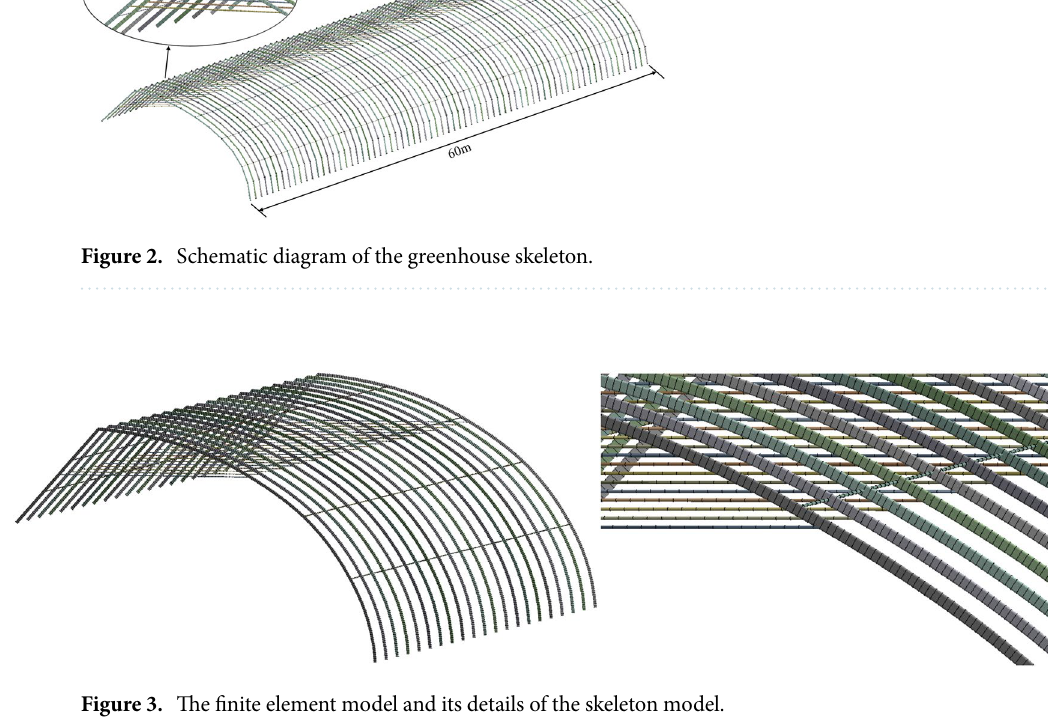
Figure 3. The finite element model and its details of the skeleton